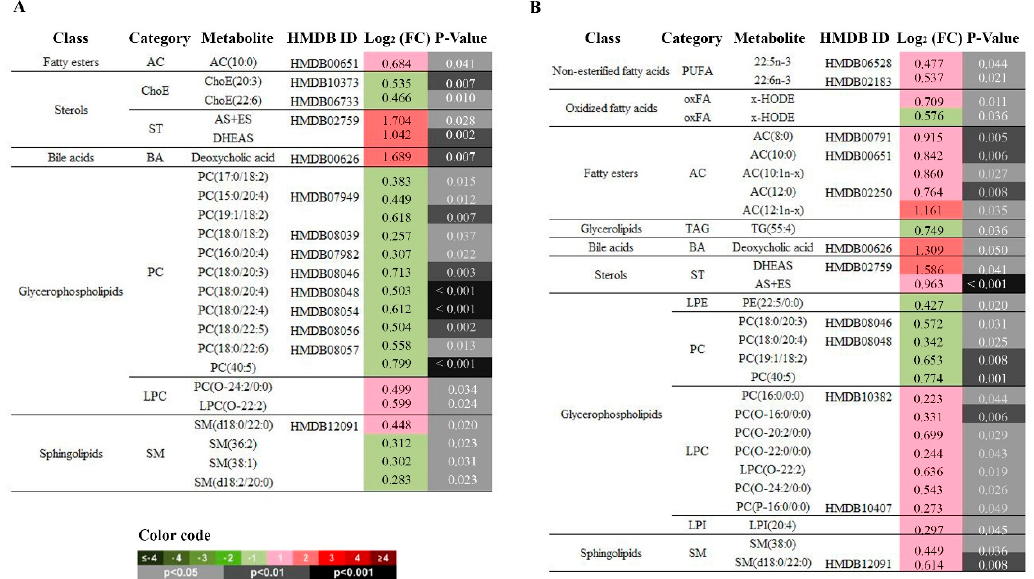
Figure 5. Impact of switching from EFV to RPV on the lipidomic profile. Relevant lipidomic changes grouped by chemical classes at ( A ) 12 weeks and at ( B ) 24 weeks of follow-up. Heatmap colour codes for log 2 (fold-change) and unpaired Student’s t-test p -values are indicated at the bottom of the figure. Abbreviations: AC, acyl carnitine; AS+ES (androsterone sulfate +